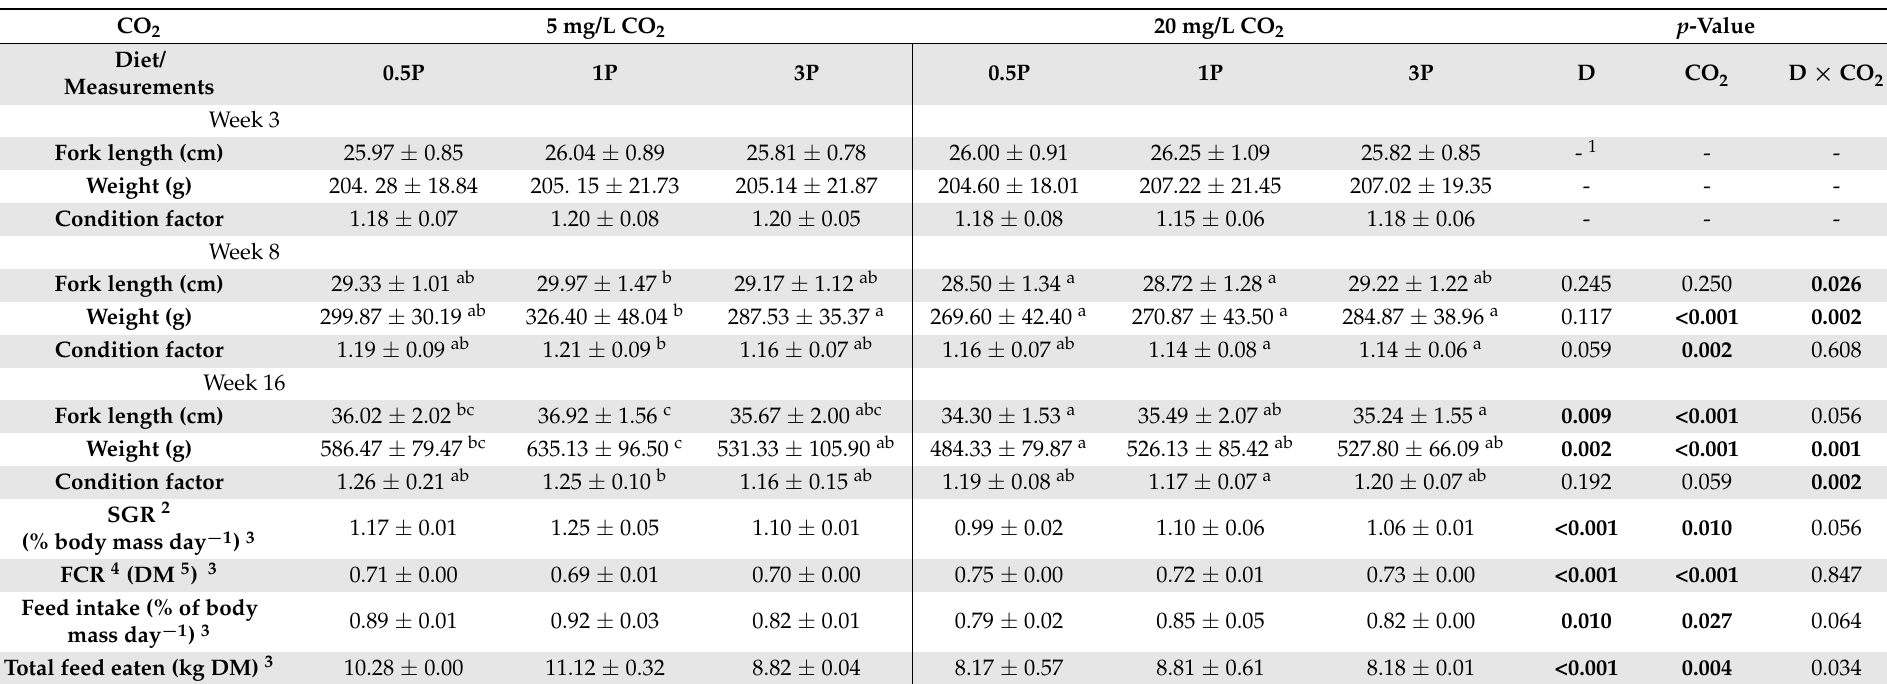
Table 3. Growth data of Atlantic salmon measured at weeks 3, 8, and 16. Animals were fed diets containing different levels of total P 0.5P (6.3 g/kg), 1P (9.0 g/kg), and 3P (26.8 g/kg) and reared in conditions with no CO 2 injected (5 mg/L) or with injected CO 2 (20 mg/L) from week 3 till week 16. The statistically significant differences among groups (within a row) are indicated by different lowercase superscript letters. For SGR, FCR, feed intake, and total feed eaten, tanks were considered as statistical replicates and variances among groups were therefore not analyzed. If none of the letters are the same, differences are significant. The significant values ( p ) for CO 2 , diet (D), and their interaction are